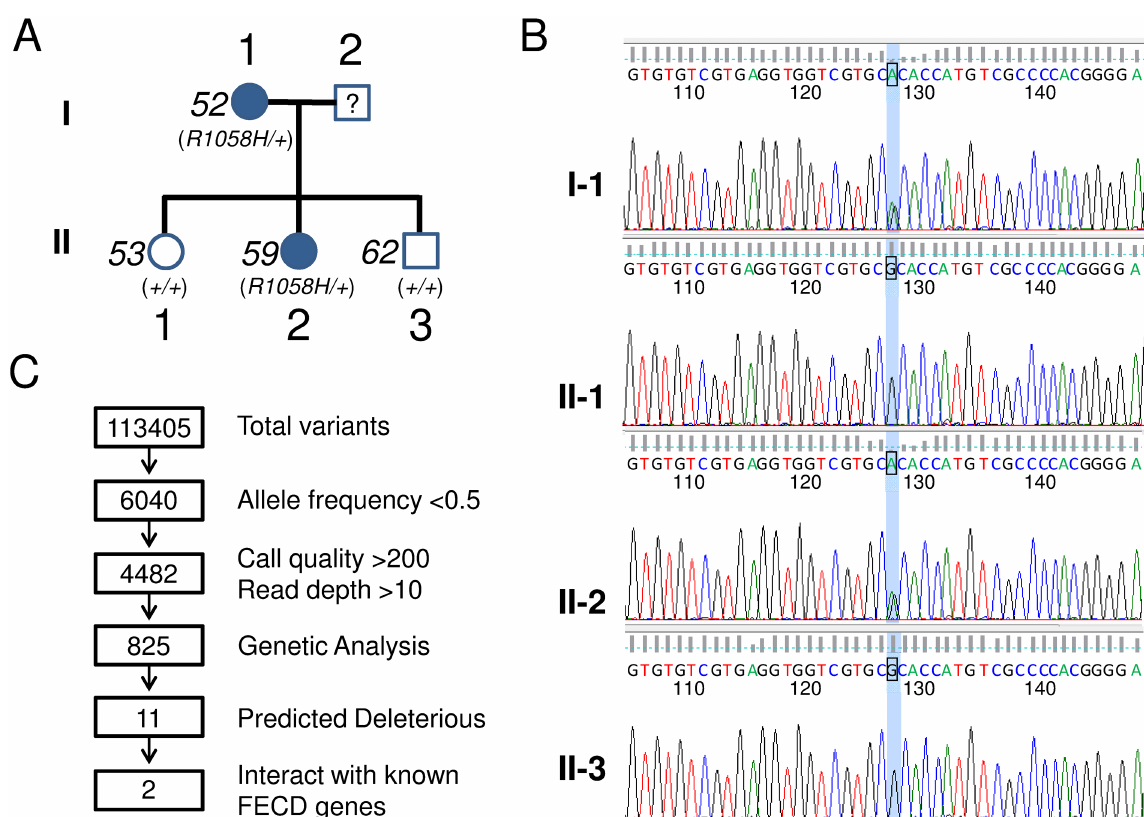
Fig 5. Identification of TSPOAP1 variants in a family with RE- FECD. (A) Pedigree of RE- FECD family. Patient 52 (91 years old) and patient 59 (64 year old) had modified Krachmer scores of 6 in both eyes and TCF4 trinucleotide repeat sizes of 18, 24 and 24, 31 respectively. Patient 53 (66 years old) and patient 62 (52 years old) had modified Krachmer scores of 0 in both eyes and TCF4 trinucleotide repeat sizes of 24, 31 and 18, 32 respectively. Outside of the FECD diagnosis, there were no evident medical conditions or syndromic diseases that were common within the pedigree other than solitary skin cancers in 2 of the 4 family members. (B) Sanger sequencing traces of DNA from the vicinity of the R1058H variant are shown. Both affected family members (I-1 and II-2) are confirmed to be heterozygous for the R1058H variant. (C) Schematic diagram showing the filtering strategy used to identify variants in exome sequencing of 4 family members. The number of variants remaining after each filtering step is shown in the boxes.